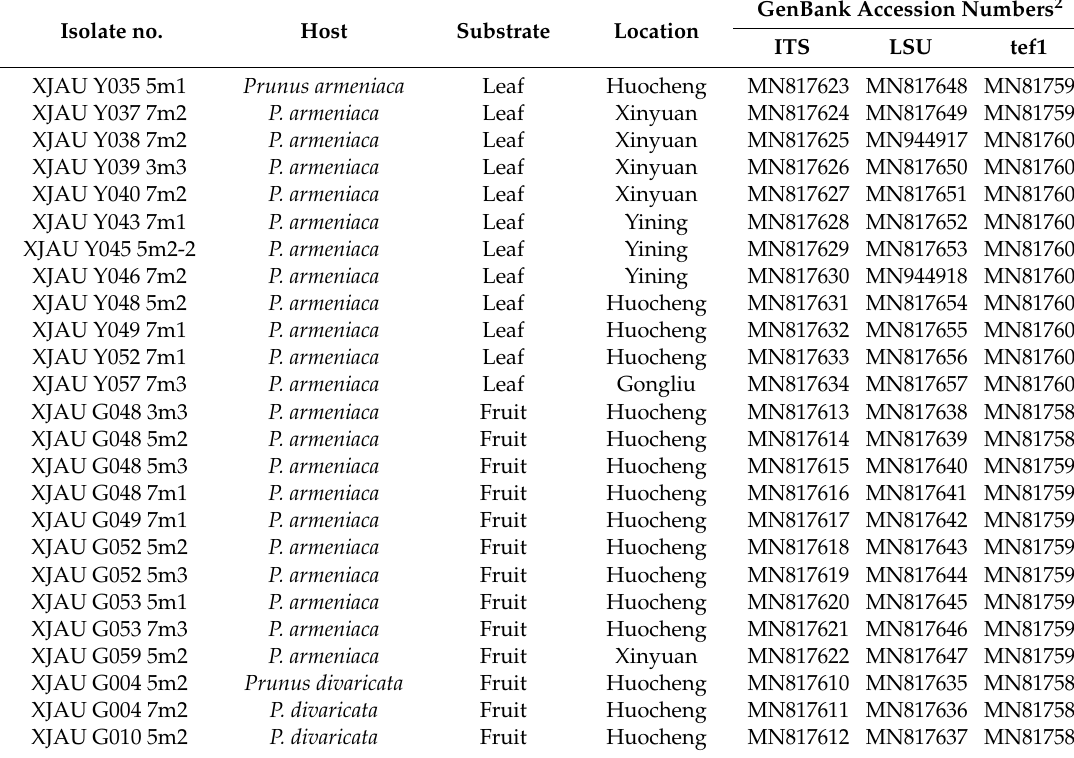
Table 1. Wilsonomyces carpophilus isolates collected and used in this study. Isolate